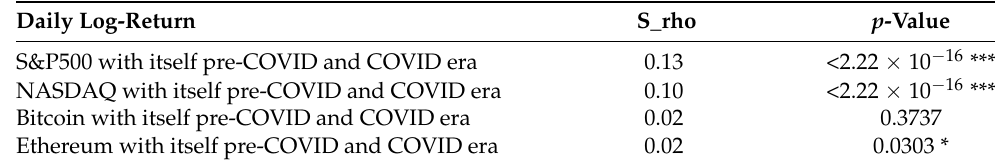
Table 3. Test equality of univariate densities: assets with themselves pre-COVID and COVID era.